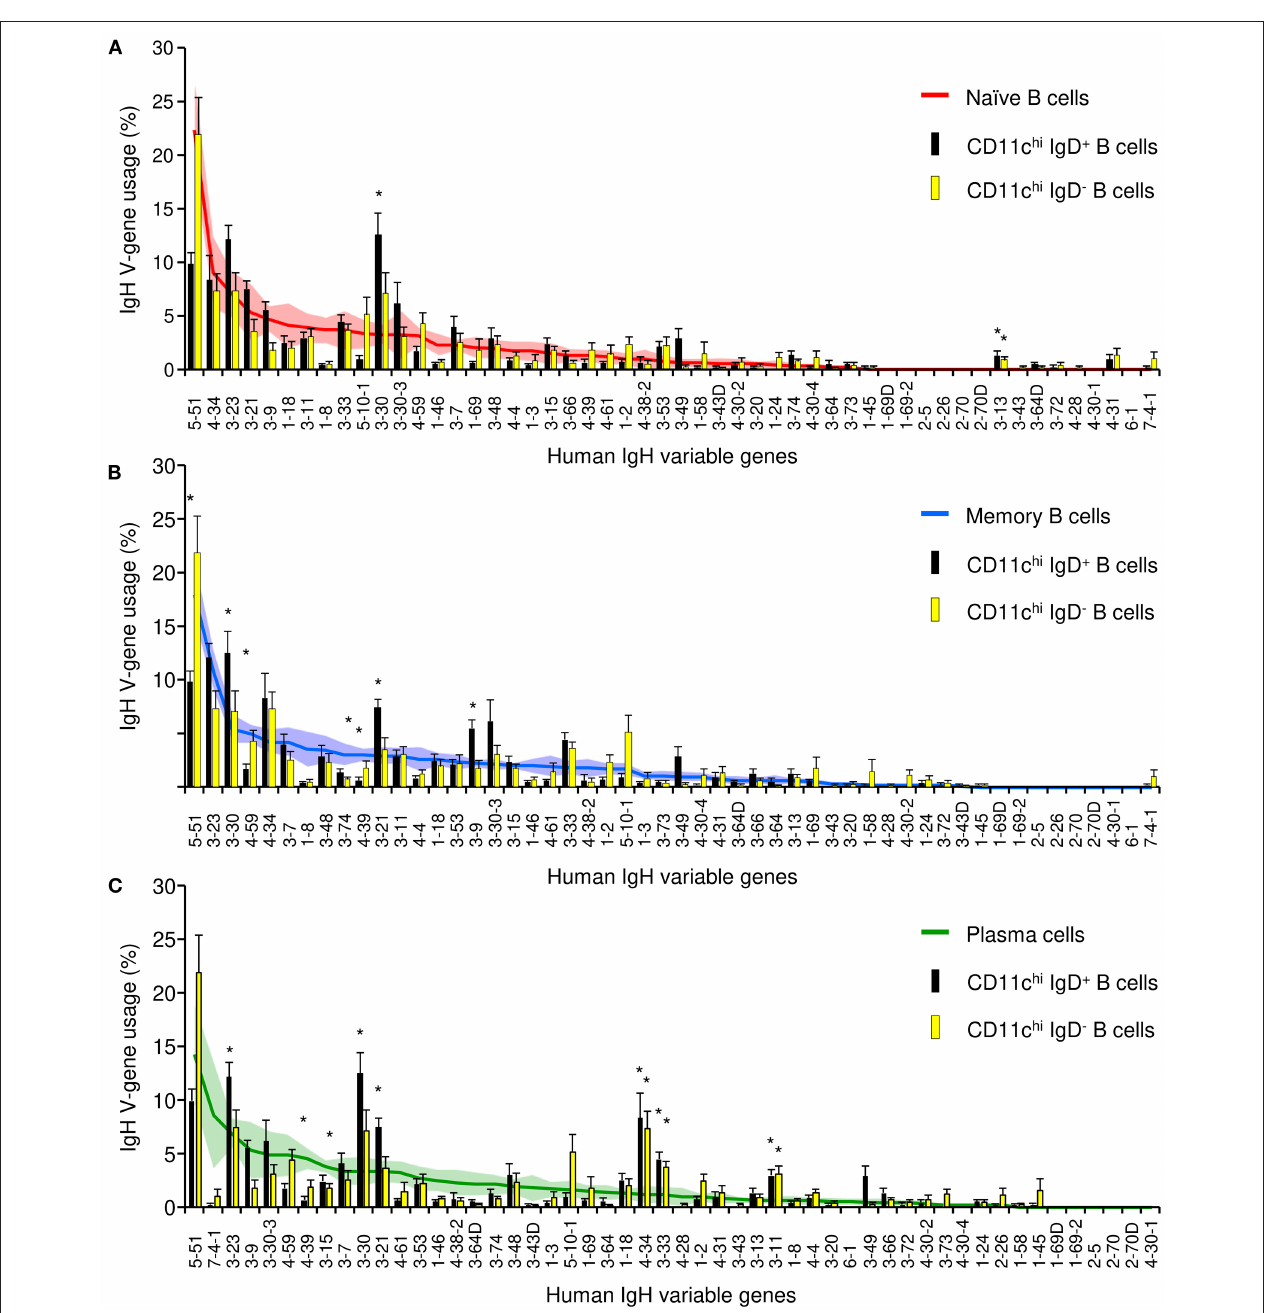
FIGURE 6 | IgH repertoire analysis of CD11c hi IgD + and IgD − B cells compared to average V-gene usage in naïve, memory, and plasma cells. Bars represent the average V-gene usage in CD11c hi IgD + (black) and CD11c hi IgD − (yellow) B cells. Lines represent the average V-gene usage in naïve ( A , red), memory ( B , blue), or plasma cells ( C , green). Shaded area and error bars represent the standard error of the mean; *represents p < 0.05 by Fisher exact test.